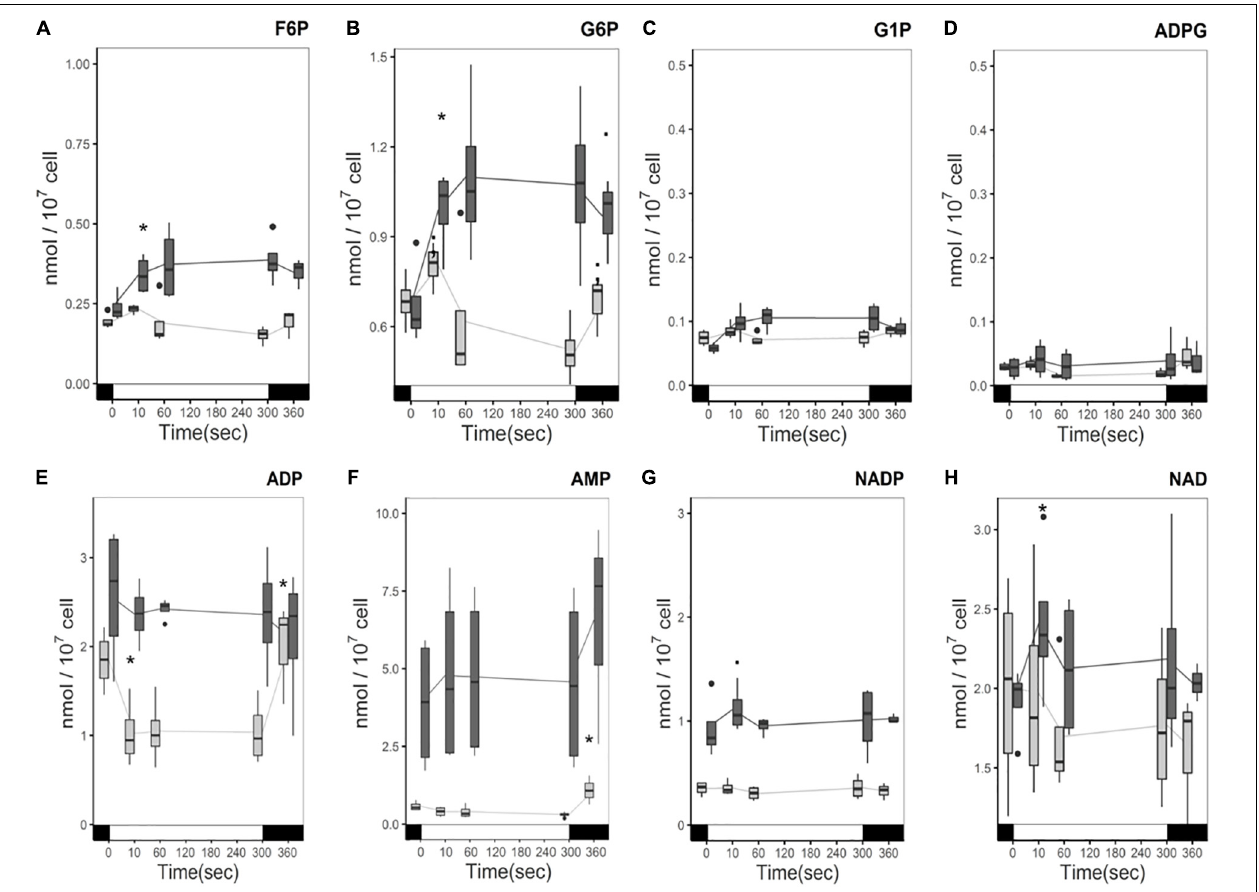
FIGURE 6 | Time course of phosphorylated pentose and hexose levels (A) F6P, (B) G6P, (C) G1P, (D) ADPG, and energy precursors (E) ADP, (F) AMP, (G) NADP, (H) NAD under illumination with (dark gray) and without (light gray) acetate. Cells were illuminated with 300 µ mol photons m − 2 s − 1 (white segment) and samples were taken at different time points. The boxplot has been built with four replicates. The line represents the mean. The dots represent outlier data that has been taken into account for standard error and statistics, designated as a dot in the whisker plot. Pairwise t -test were performed between time points (one square, p < 0,1; one asterisk, p < 0.05; two asterisks, p < 0.01). Light has a significant effect on the accumulation of F6P, G6P, and ADP ( p -value < 0.05), and AMP ( p -value < 0.01) in the absence of acetate. No significant effect of either acetate or light was found on G1P or